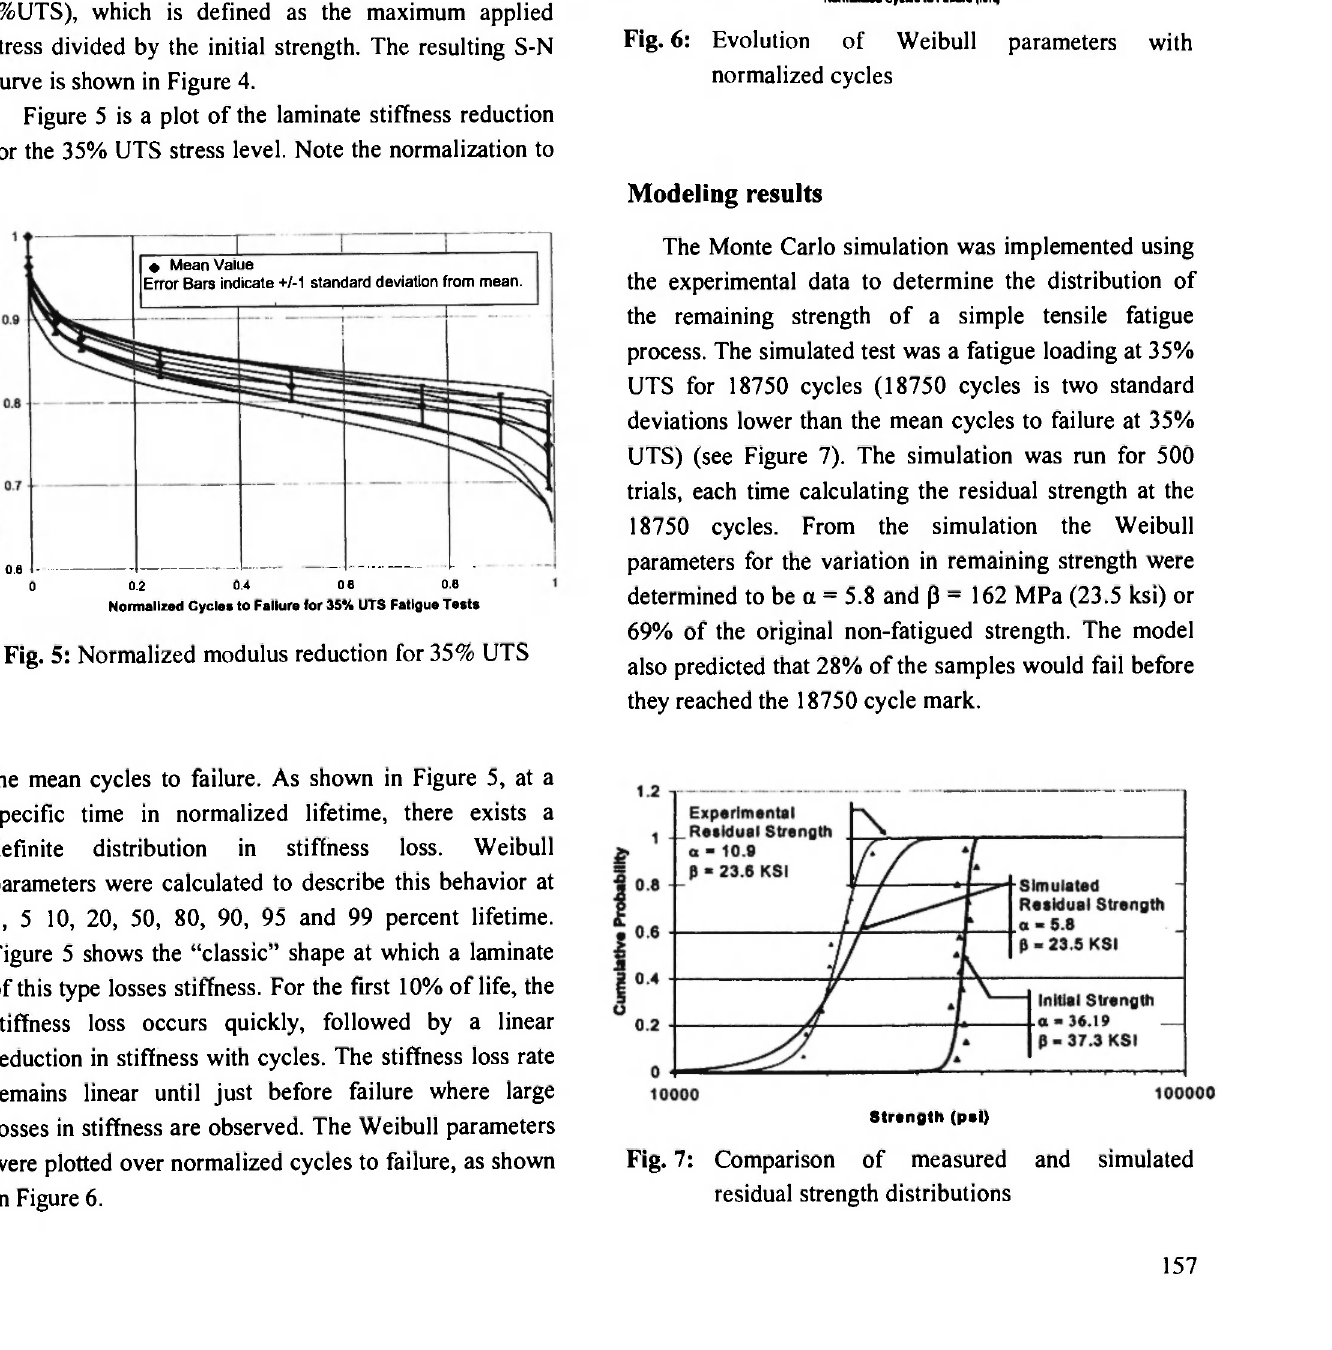
Fig. 7: Comparison of measured and simulated residual strength